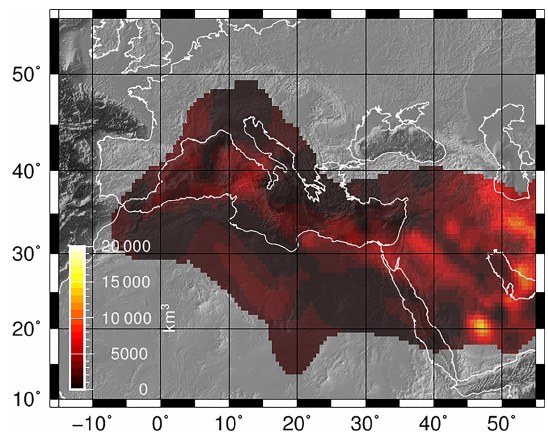
Figure 10. Volume of subducted oceanic lithosphere (in km 3 ) for the western Tethyan region for the past 200Myr. The amount of material was calculated based on paleo-age grids with a 6arcmin grid cell size for the subducted oceanic lithosphere (see Müller et al., 2008, for methodology) and convergence velocities derived from the input plate kinematic model. We assume a simple half- space cooling model to compute the thickness of the oceanic √ lithosphere for ages<69.9Myr as z = 11 . 36 age, where age is the age of the oceanic lithosphere. Older lithosphere is set to a default thickness of 95km (Kanamori and Press, 1970). Volumes are derived by multiplying thickness with computed trench-normal convergence in 1Myr time steps. Grid cell size for the subduction volume is 30arcmin. Map background is ETOPO1 topography (Amante and Eakins,